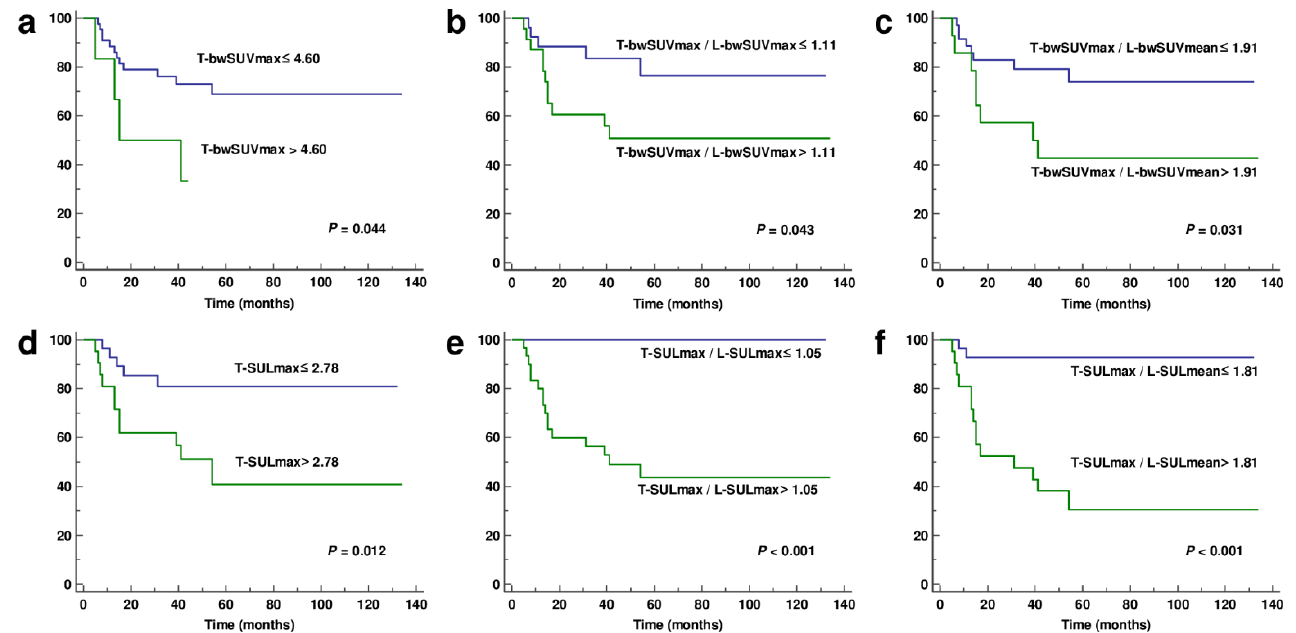
Figure 3. Kaplan–Meier analysis of recurrence-free survival according to metabolic parameters. Six-